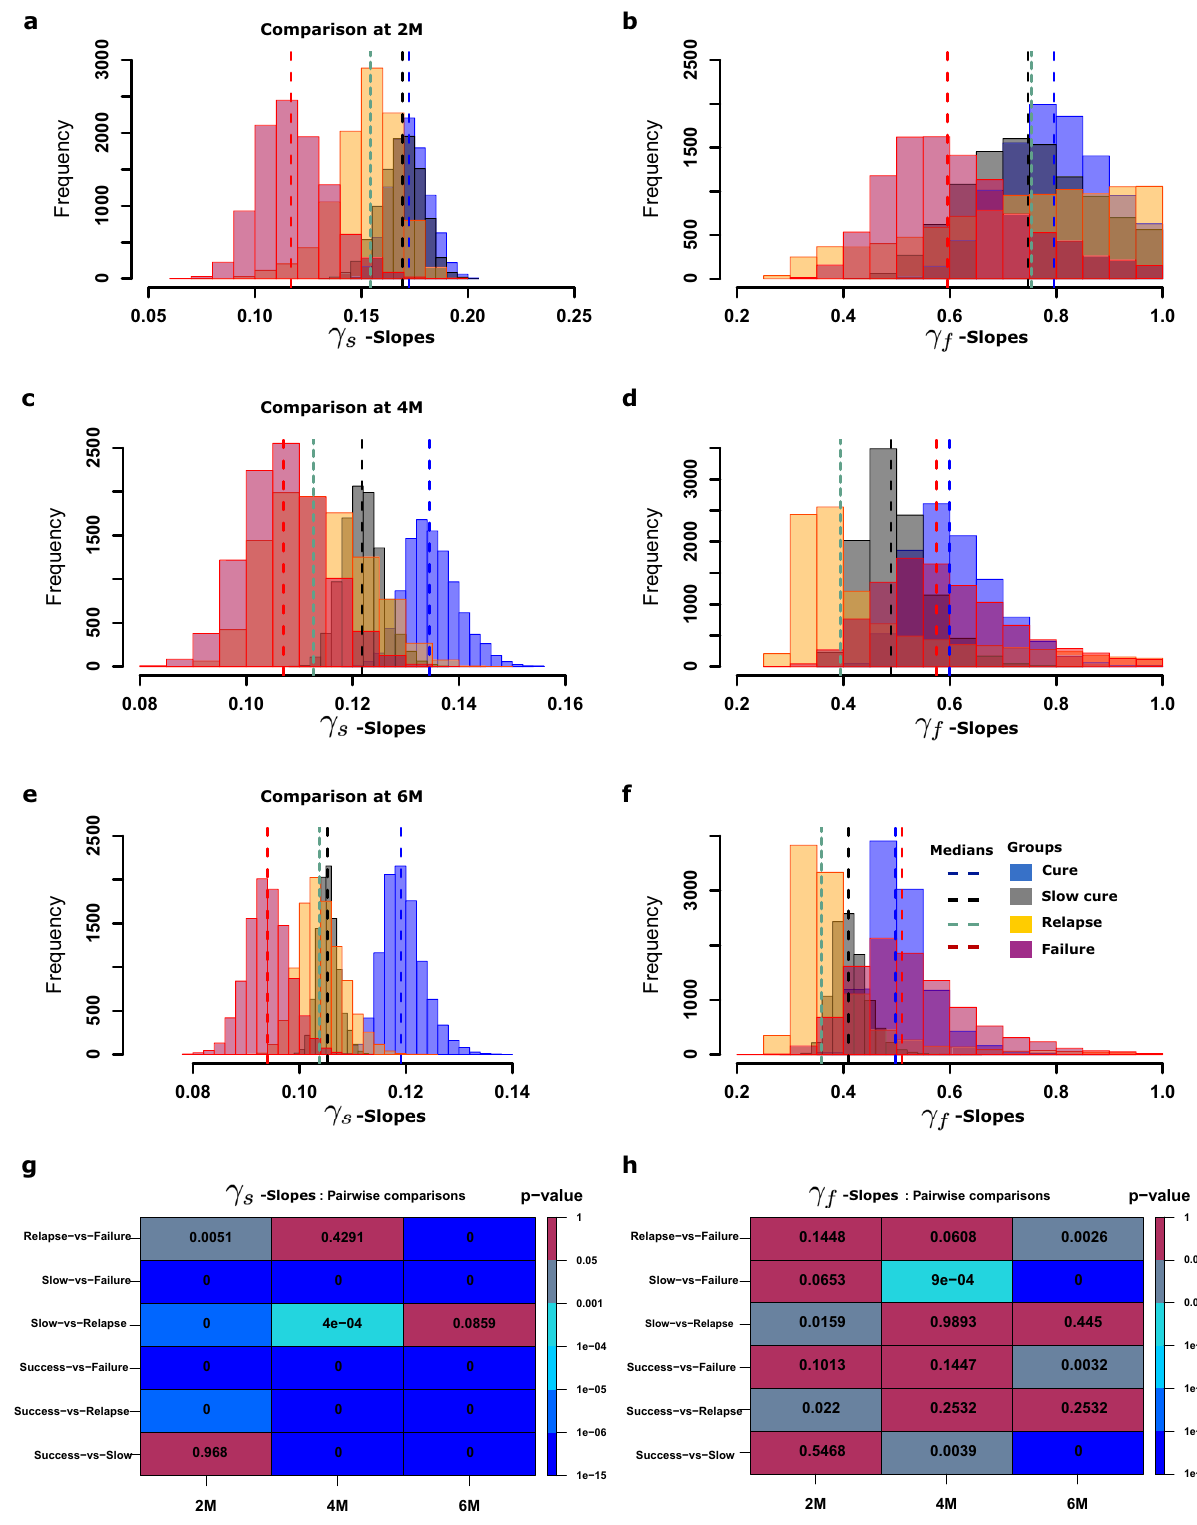
Fig. 4 Distributions of model estimated kill rates/biomarkers. Distributions of γ s - and γ f -slopes based on 2-months, 4-months and 6-months accrued TTP data. a γ s -slopes based on 2 months TTP data, b γ f -slopes based on 4 months TTP data, and c γ s -slopes based on 6 months TTP data. d The magnitude of γ f -slopes at 2 months, e at 4 months, and f at the end of 6 months. g Pairwise analysis using the Mann – Whitney test for distributions of slopes based on 2, 4 and 6 months data versus each cluster (cure, slow-cure, relapse and failure) for the γ s -slopes shows p -values in each cell that were signi fi cant even with 2-months of data, except with cure versus slow cure group. h Pairwise statistical difference analysis for γ f , found that few p -values were signi fi cant, and even those had an inconsistent